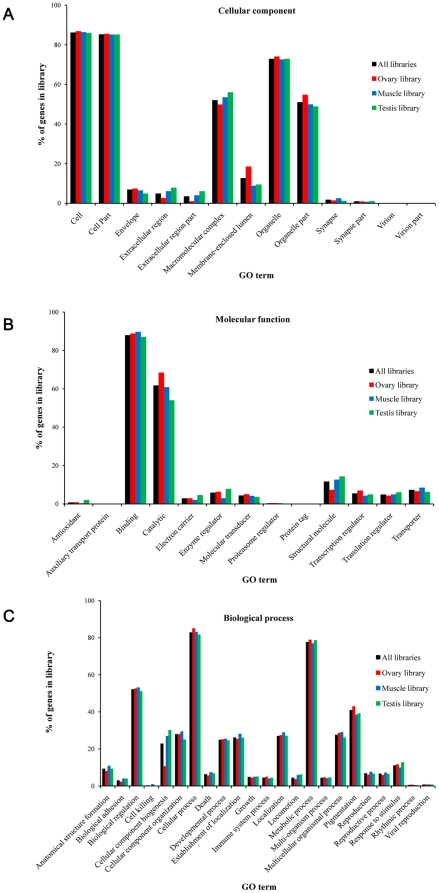
Gene ontology (GO) terms for the transcriptomic sequences of M. rosenbergii and comparison of among libraries.(A) cellular component, (B) molecular function and (C) biological process.